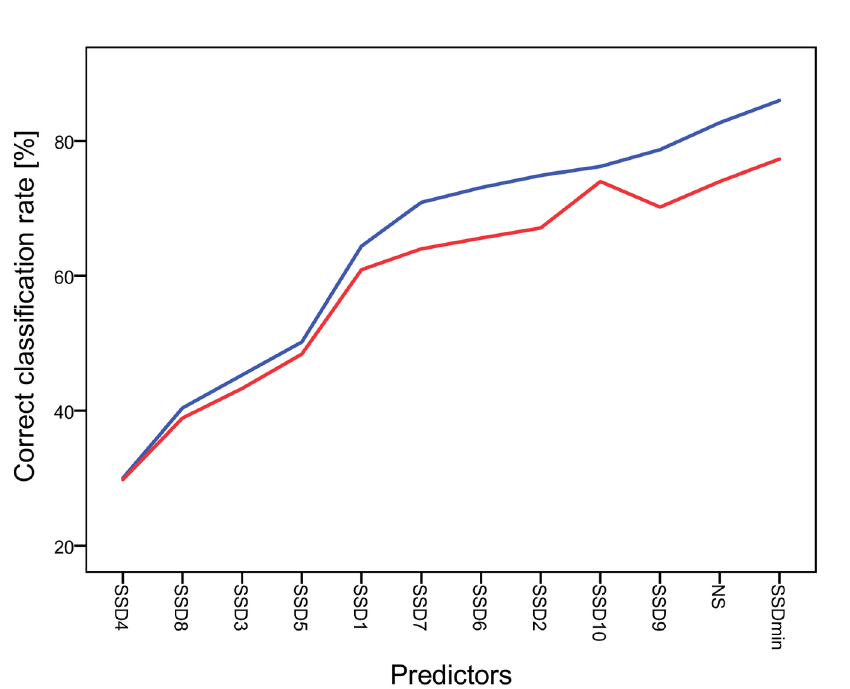
Fig 3. Changes in correct classification rate in models with different number of predictors. Null model contained one predictor, that with the highest PIC value. In each successive model we added the predictor with the next-highest PIC value; the final model contained 12 predictors. The correct classification rate (blue line) and correct classification rate in leave-one-out classification (red line) are given. Analysis is based on 33 individuals. NS -number of strokes; SSD1-10 –first ten stroke-to-stroke durations, SSDmin—minimum